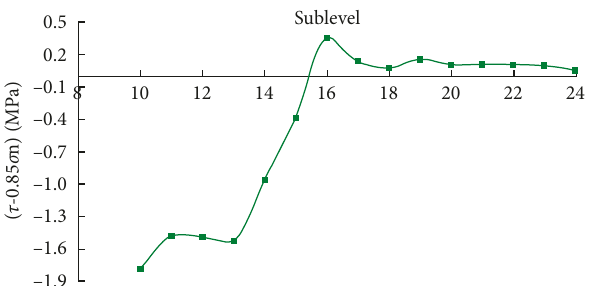
Figure 11: Sliding property of fault F3 changes with mining depth.